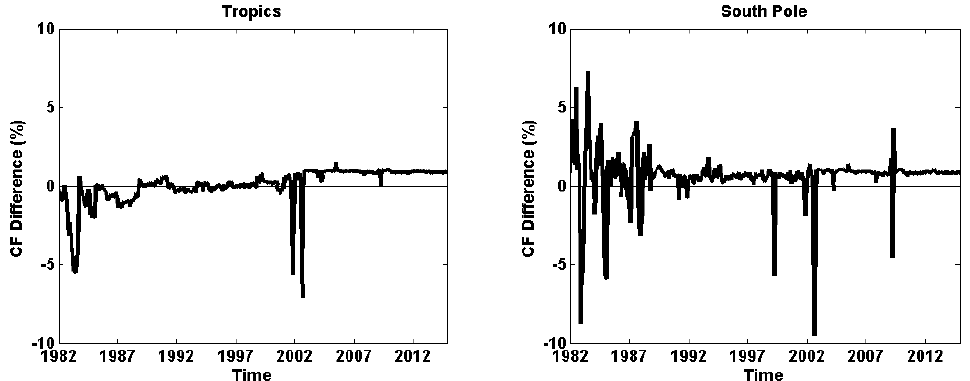
Figure 7. Mean cloud fraction difference (% cloud cover) in the tropical region (Tropics) and the South Pole region for the entire time period 1982–2015 between the final version of CLARA-A2 and the original CLARA-A2 version. The impact of channel 3b filtering is visible in the period 1982–1999 (see text).